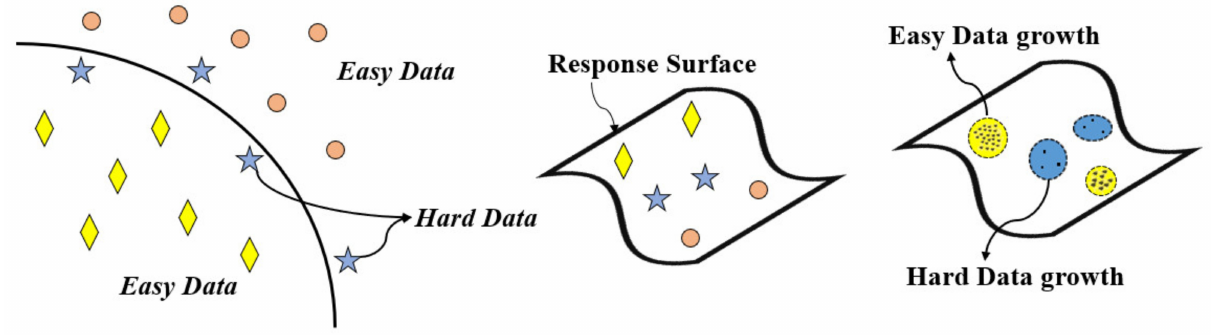
Figure 5. Point-wise population based on the easy/hard data.